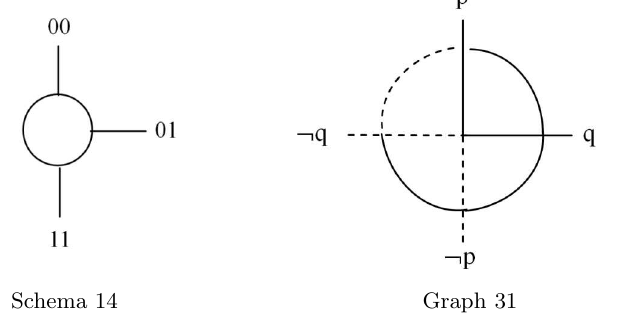
Schema 14 stands for a two-place basic formula: ⌊ p q ⌋ (pq), while graph 31 (also see graph 10(d), 11(a)) stands for assertions: ⊢ ¬ p ∨ q, ⊢ p → q. Both schema 14 and graph 31 mean that the whole expression is true iff ‘p’ is false (has value 0) and ‘q’ is true (has value 1), or, both ‘p’ and ‘q’ are true, or, both ‘p’ and ‘q’ are false.